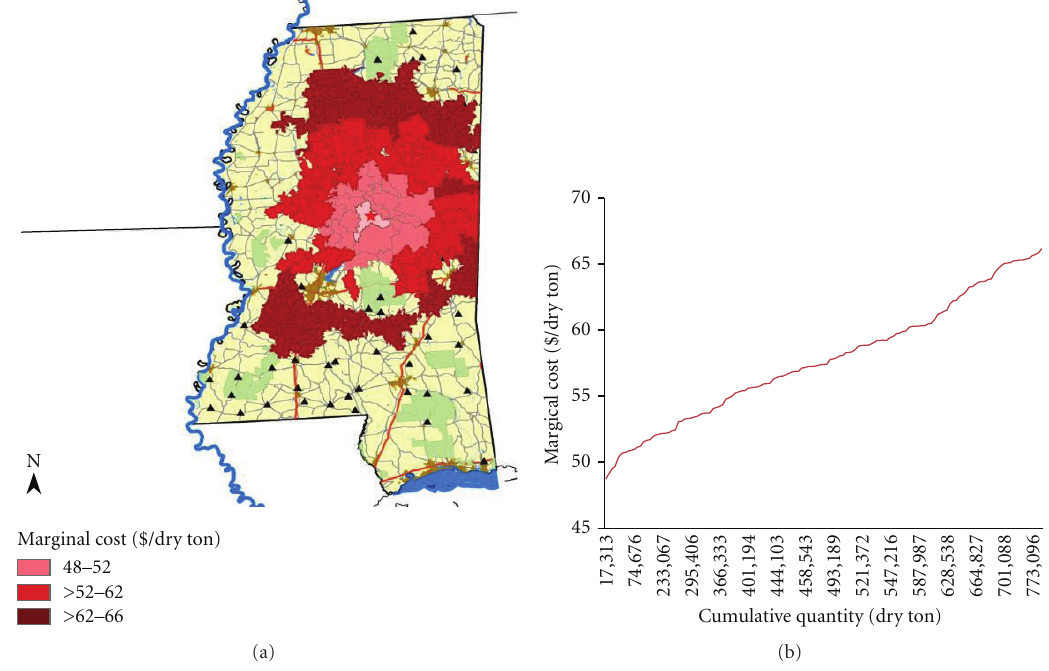
Figure 8: Spatial representation of biobasin for ZCTA 39090 (Kosciusko MS) and associated marginal cost curve for pine pulpwood ( pinus spp.) from the BioSAT